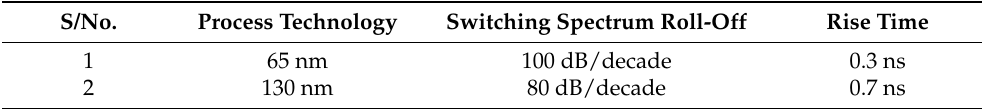
Table 1. Comparison of the simulation results. S/No.